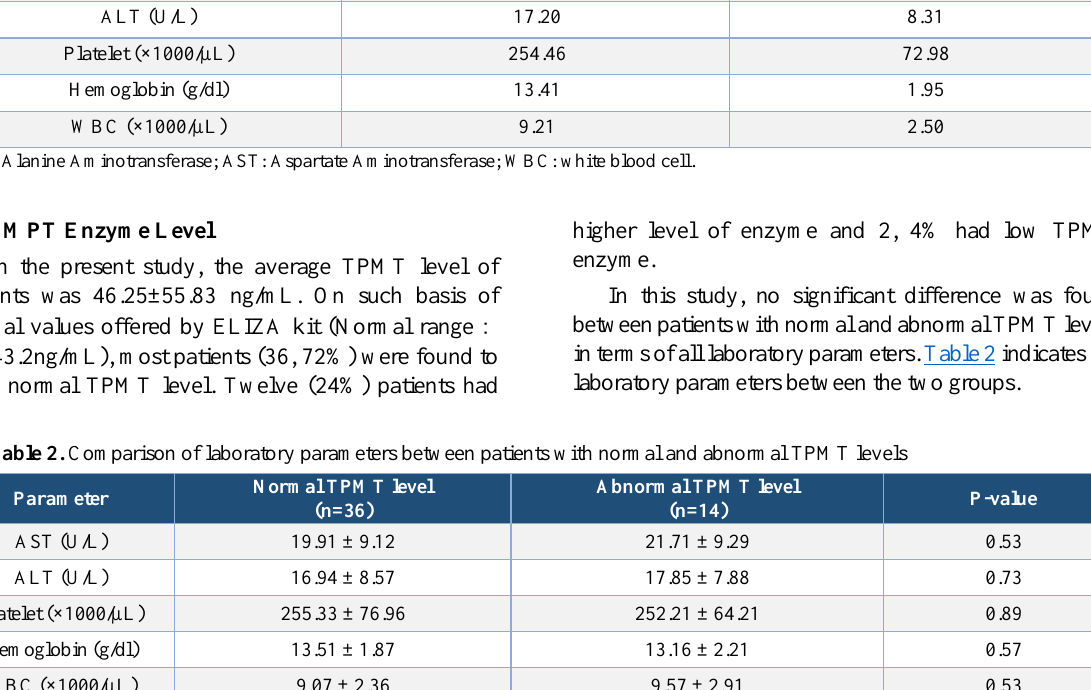
Table 1. Laboratory results of the PV patients receiving thiopurine drugs Parameter Mean SD AST (U/L)